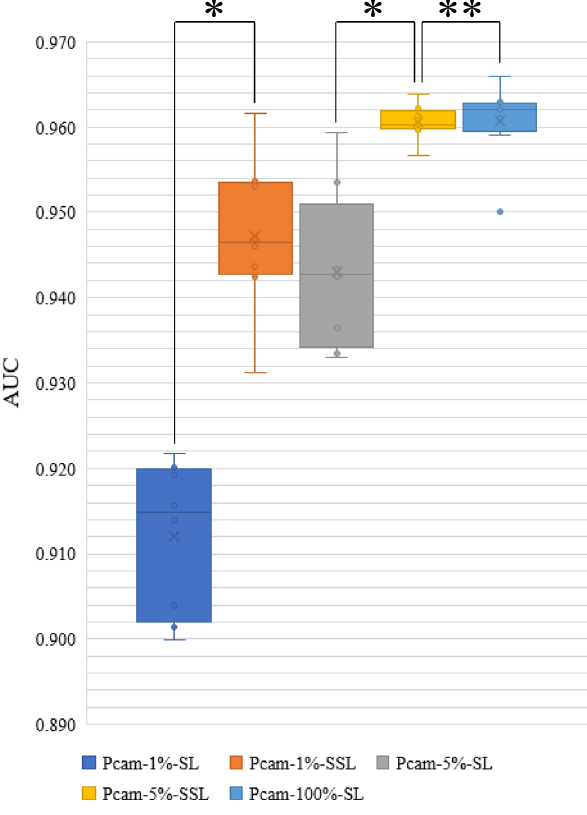
Fig. 6 Area under the curve (AUC) distribution of fi ve models on the testing set of PatchCamelyon data set (number of samples/patches per testing set = 32,768; number of experiments per model = 8). The boxes indicate the upper and lower quartile values, and the whiskers indicate the minima and maxima values. The horizontal bar in the box indicates the median, while the cross indicates the mean. The circles represent data points, and the scatter dots indicate outliers. * indicates signi fi cant difference, and ** indicates no signi fi cant difference. The Wilcoxon-signed rank test (sample size/group = 8) is then used to evaluate the signi fi cant difference of AUCs between the two models. Two-sided P values are reported, and no adjustment is made. The average AUC and standard deviation (sample size = 8) are calculated for each model. Pcam-1%-SSL vs. Pcam-1%-SL: 0.947 ± 0.008 vs. 0.912 ± 0.008, P value = 0.012;